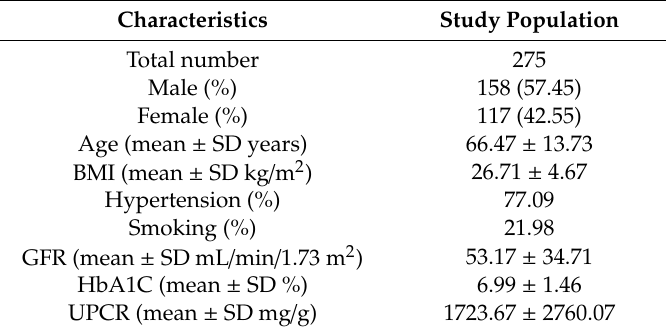
Table 1. Baseline characteristics of the study